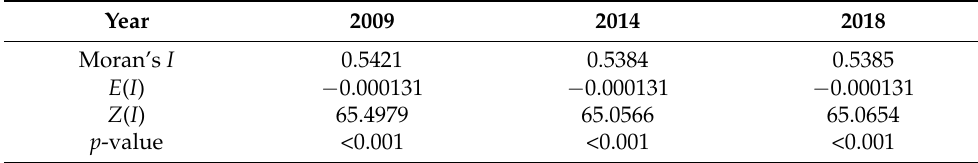
Table 5. Sensitivity of ESV to its value coefficient in Wu’an